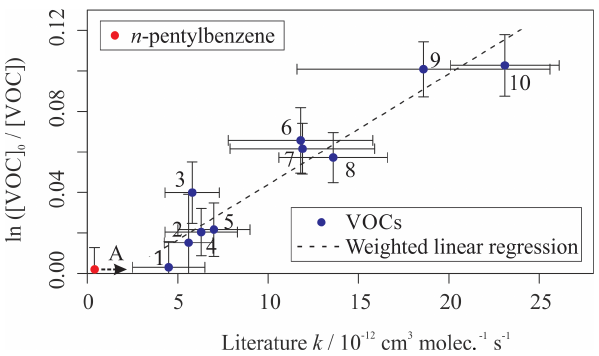
Figure 2. Relative rate plot for Mixture 2 (OH reactivity of 18s − 1 ) in the absence of NO at 296 ( ± 2)K. Compounds with a reference rate coefficient for reaction with OH were plotted using evaluated literature values. Error bars on the y axis, equal to 1 standard er- ror, were calculated by combining the standard error in peak areas for six lamp-off and six lamp-on samples. Error bars on the x axis were typically large (approximately ± 20%–30%) and accounted for deviations from the predicted trend for most VOCs. A weighted (to the uncertainty in the y values) linear fit was used to gen- erate the slope with OH exp = 5 . 5 ( ± 0 . 6 ) × 10 9 molec.cm − 3 s and R 2 = 0 . 899. Data for n -pentylbenzene (A) were not used in the cal- culation of OH exp but were included on the plot to illustrate its mea- sured depletion factor. The dashed arrow indicates that the k value for the target compound is determined by where it would fall on the measured OH exp curve. The VOCs can be identified as follows: 1, t - butylbenzene; 2, toluene; 3, n -propylbenzene; 4, isopropylbenzene; 5, ethylbenzene; 6, 2-ethyltoluene; 7, 4-ethyltoluene; 8, o -xylene; 9, 3-ethyltoluene; 10, m -xylene.